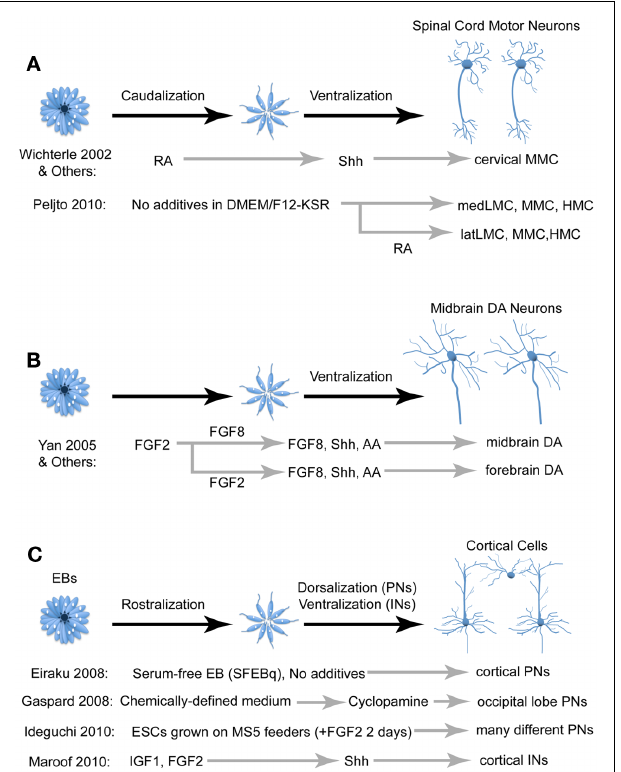
FIGURE 4 | Comparison of different techniques for deriving three of the more studied neural cell types: spinal motor neurons (A), midbrain dopaminergic neurons (B), and cortical cells (C). FGF, fibroblast growth factor; RA, retinoic acid; Shh, Sonic hedgehog; IGF, insulin growth factor; AA, arachidonic acid; PN, projection neurons; IN, interneurons; MMC, median motor neurons; LMC, lateral motor neurons; HMC, hypaxial motor neurons; DA,